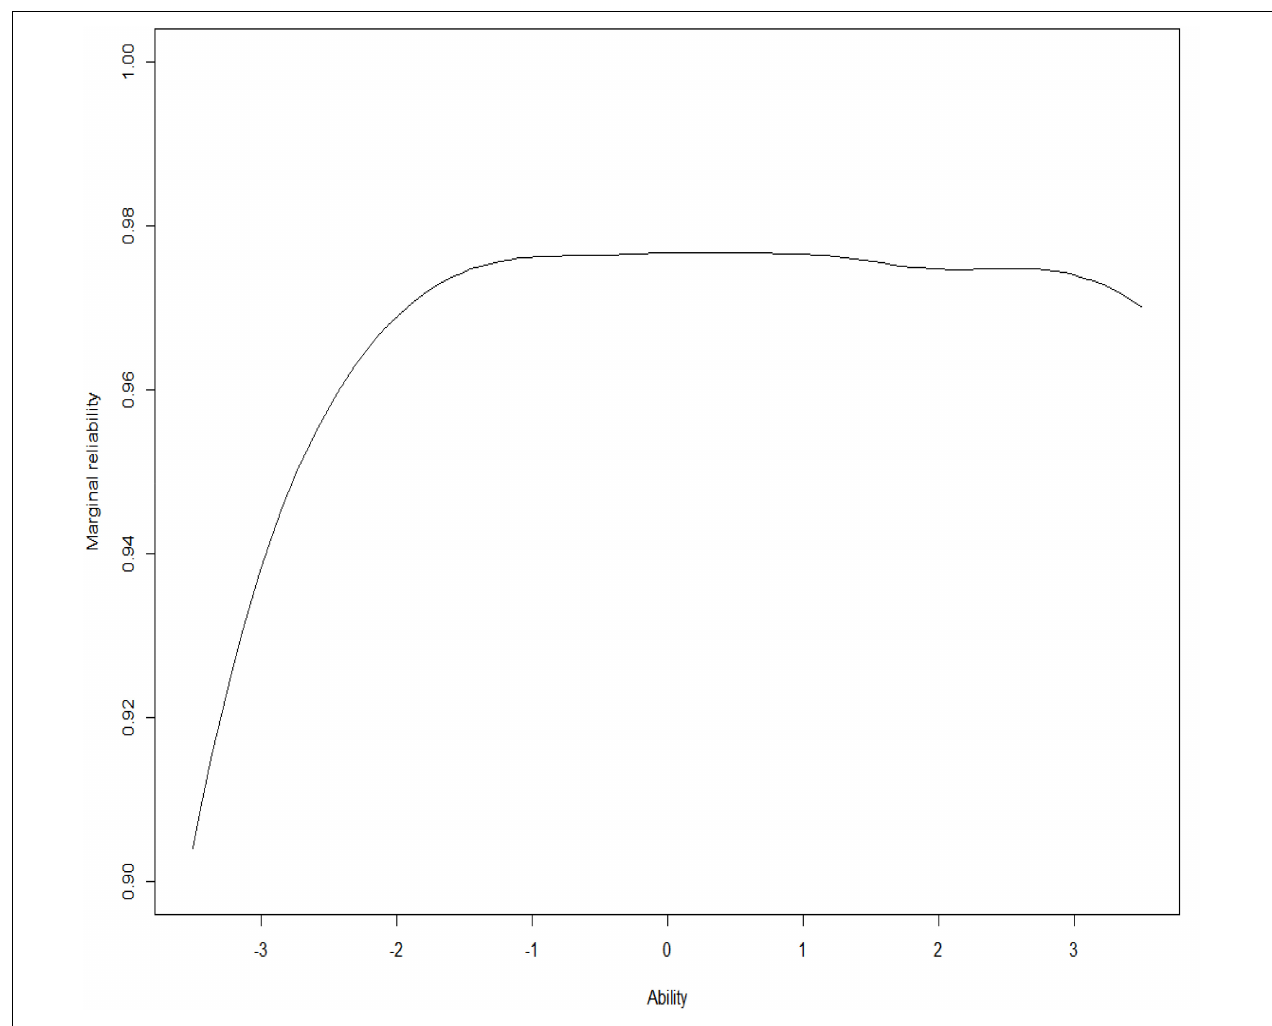
FIGURE 4 | Item bank marginal reliability curve.